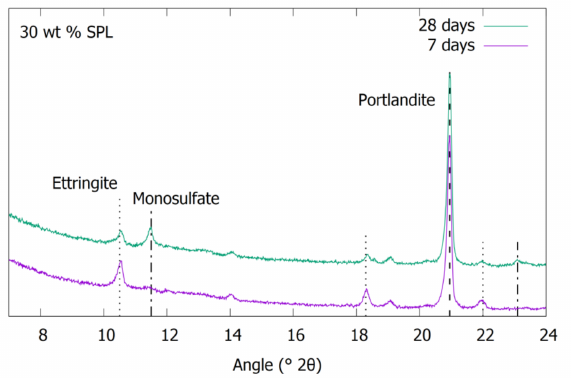
Figure 6. X-ray diffractogram of the hydrated pastes including 30 wt% of spent pot lining aluminosil- icates. The hydrates are indicated and other peaks result from unreacted